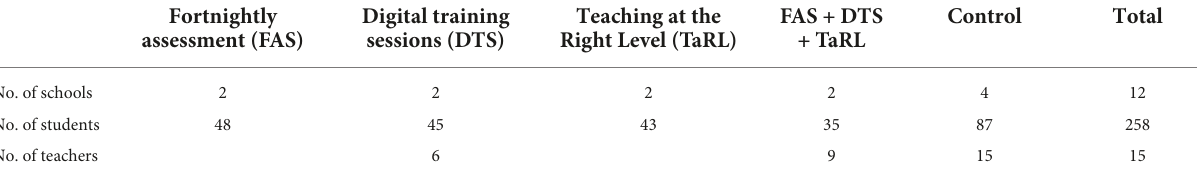
TABLE 1 Distribution of treatment groups across 12 schools at